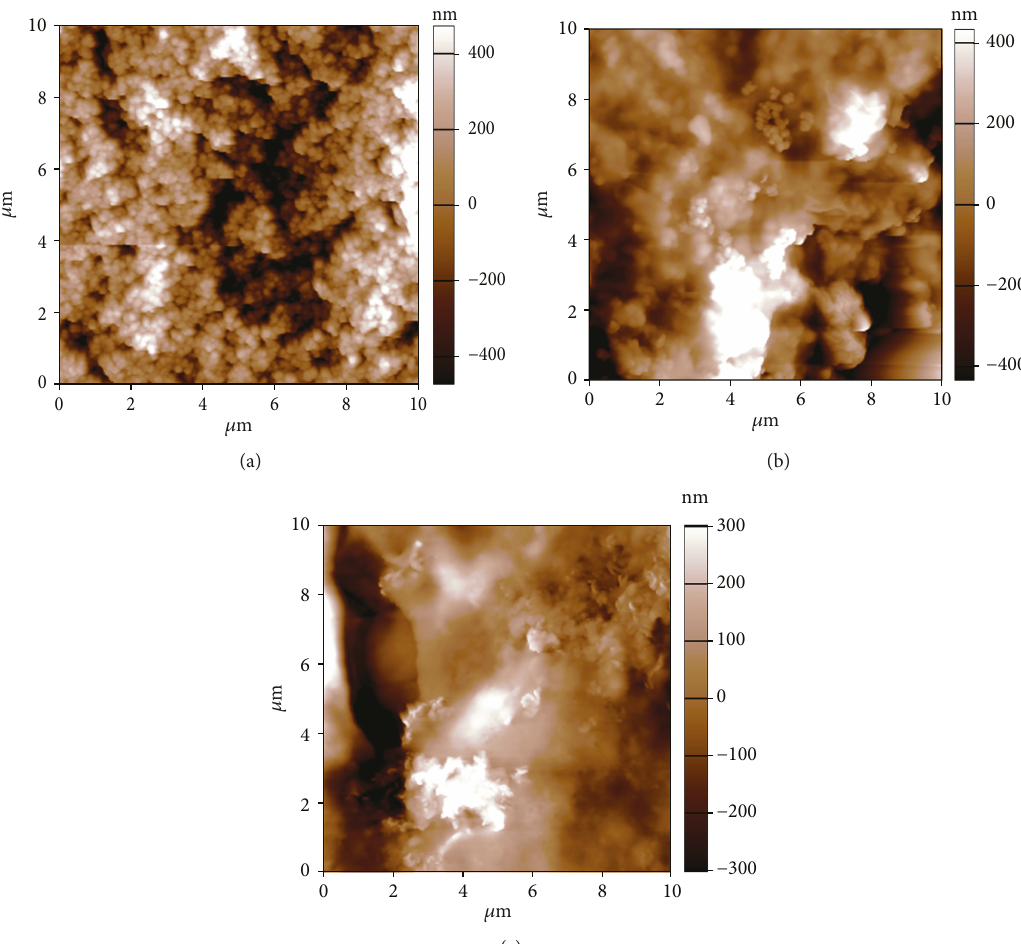
Figure 5: AFM images of (a) TiO